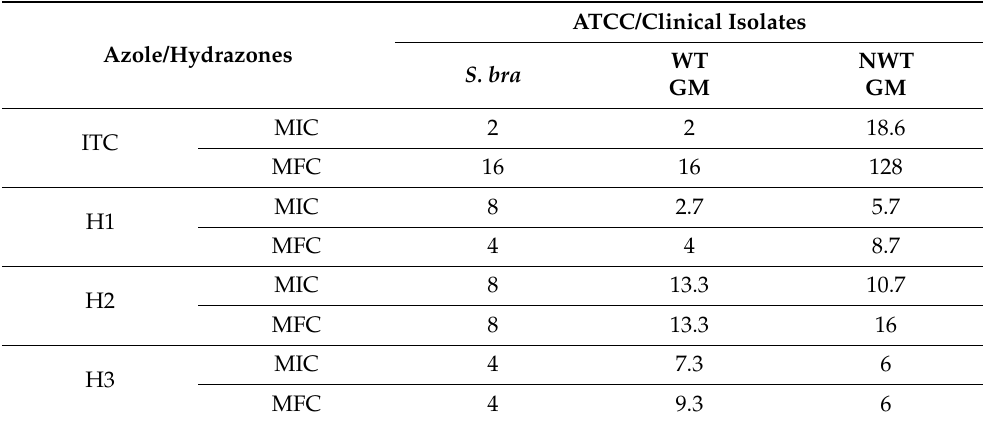
Table 3. Geometric means generated from the in vitro susceptibility (µg/mL) of the six isolated Sporothrix brasiliensis (yeast forms) to novel hydrazone derivatives.